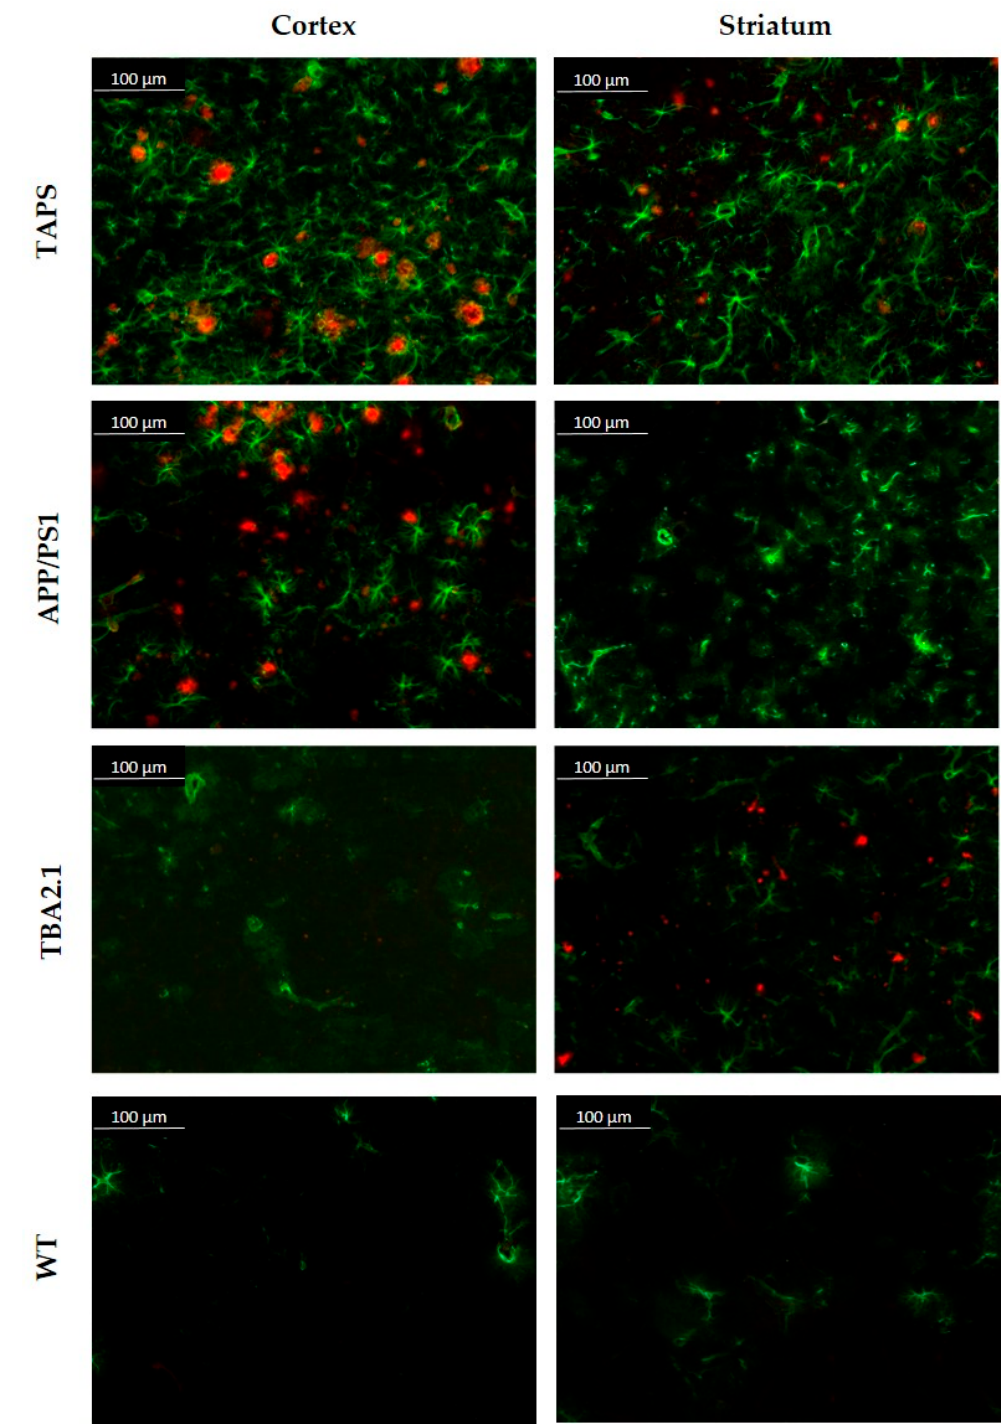
Figure 3. Amyloid- β plaque pattern and reactive astrogliosis in TAPS, APP/PS1, TBA2.1, and wild- type (WT) mice at 200x magnification. Immunofluorescence analysis of A β (red, 6E10) and reactive astrocytes (green, GFAP). Both, TAPS and APP/PS1 mice showed abundant plaque load throughout the whole cerebral cortex, accompanied by strong reactive astrogliosis. TBA2.1 mice seemed to lack such aggregation of A β in this area. Reactive astrogliosis in the cortex was on comparable low levels, as observed in WT mice. In the striatum, only TAPS and TBA2.1 mice showed higher amounts of A β aggregates, which could not be observed in APP/PS1 mice. Images of representative animals are shown; for total animal numbers, see Table 1.